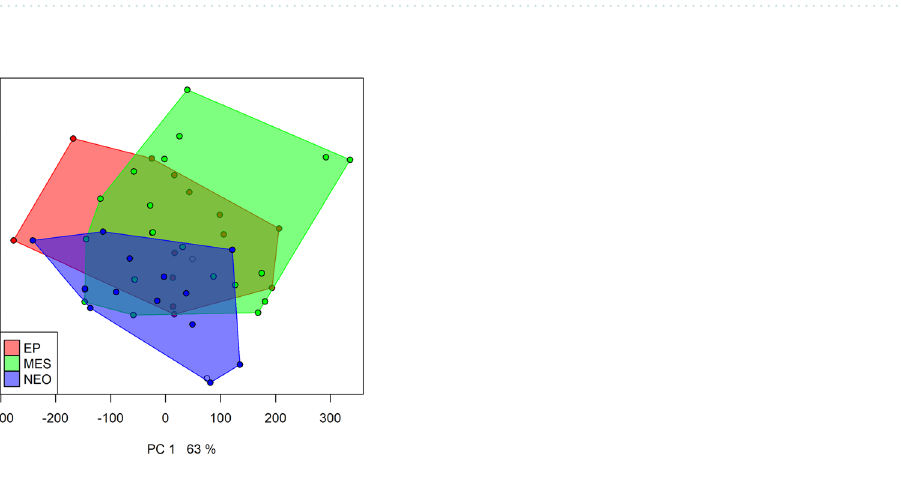
Figure 4. Scatterplot of the first and second principal component